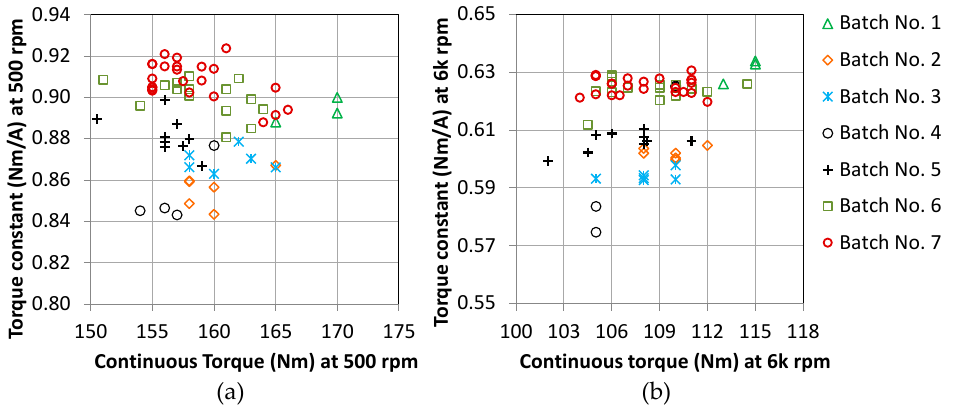
Figure 4. Torque constant vs. continuous torque measured at two different speeds for each AF PMSM tested: ( a ) 500 rpm; ( b ) 6000 rpm.